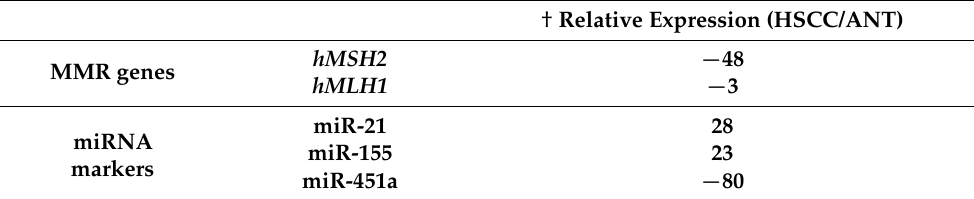
Figure 6. Downregulation of hMLH1 gene in human HSCC from tobacco smokers ( A ). Graphs depict mRNA levels of hMLH1 (mean ± SD) were normalized to hGAPDH; by real-time qPCR analysis) for ( a ) total and ( b ) each of the analyzed human HSCC excised from tobacco smokers compared to corresponding adjacent normal tissue (ANTs). (by t test; *, p < 0.05; ****, p < 0.00005; multiple comparisons by Holm-Sidak; GraphPad Prism 7.0; data obtained from at least three repetitions). ( B ). Graph depicts the mRNA ratios of hMLH1 gene in HSCC from smokers compared to ANTs (normalized mRNAs to hGAPDH reference control). Table 3. MMR mRNA and * miRNA phenotypes associated with human HSCC from smokers. † Relative Expression